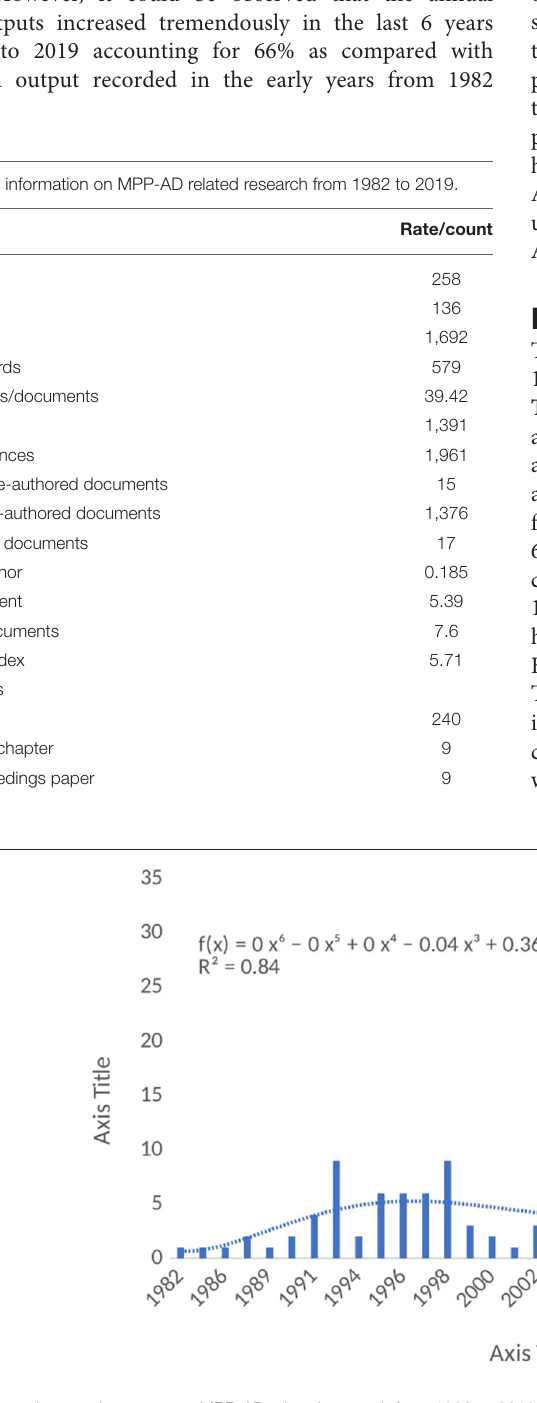
FIGURE 2 | Annual research outputs on MPP-AD related research from 1982 to